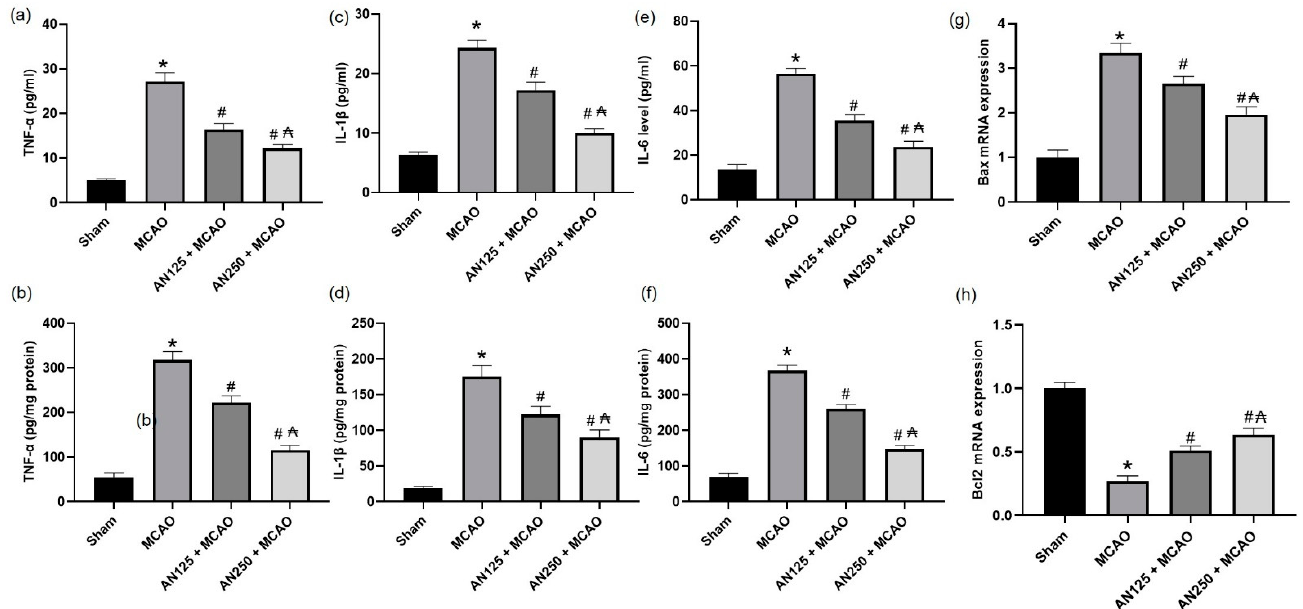
Figure 7. The impact of pretreatment with anethole (AN, 125, 250 mg/kg, orally) for two weeks in Figure 1. The impact of pretreatment with anethole (AN, 125 and 250 mg/kg, orally) for two weeks MCAO-induced cerebral ischemia/reperfusion in rats on serum and brain tissue homogenate of ( a ), in MCAO-induced cerebral ischemia/reperfusion on ( a ) infarct volume, ( b ) neurological deficits, ( c ) ( b ) TNF- α , ( c , d ) IL-1 β , ( e , f ) IL-6 and the gene expression of ( g ) Bax and ( h ) Bcl2, respectively. Data Evans blue concentration and ( d ) brain water content percentage. Data are expressed as mean ± SD are expressed as mean ± SD ( n = 6). * significantly different from the sham-operated group, # signif- ( n = 6). * significantly different from the sham-operated group, # significantly different from the icantly different from the MCAO ischemic group, and ₳ significantly different from the AN125 + MCAO ischemic group, and ₳ significantly different from the AN125 + MCAO group at p < 0.05 MCAO group at p < 0.05 using ANOVA followed by Tukey’s post hoc test. using ANOVA followed by Tukey ’ s post hoc test. AN125 + MCAO group at p < 0.05 using ANOVA followed by Tukey’s post hoc